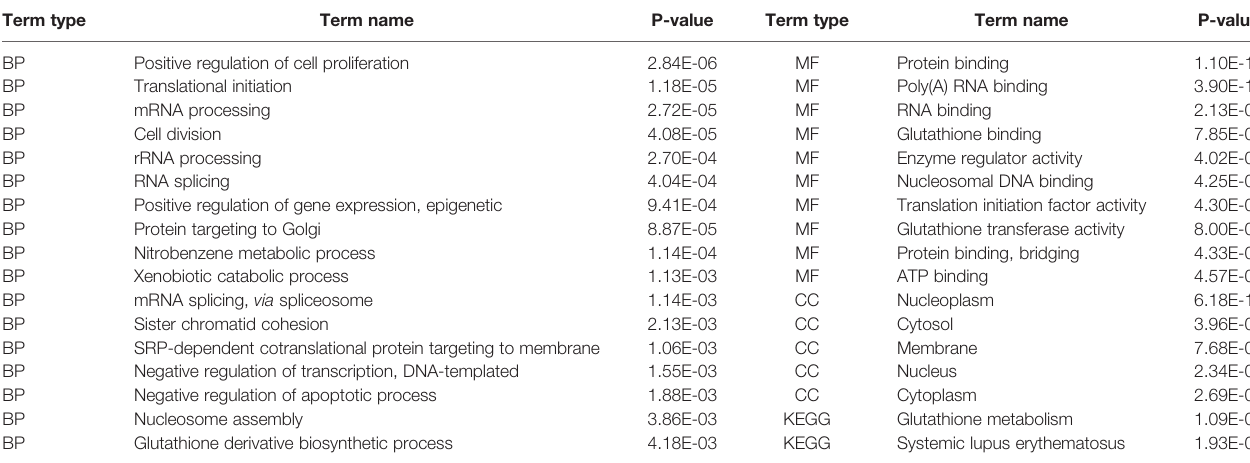
TABLE 1 | Functional enrichment of genes in the identi fi ed